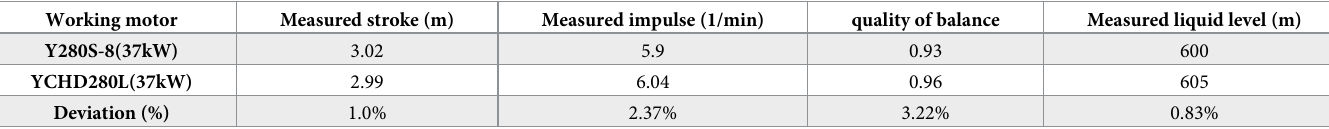
Table 3. Test conditions parameter test